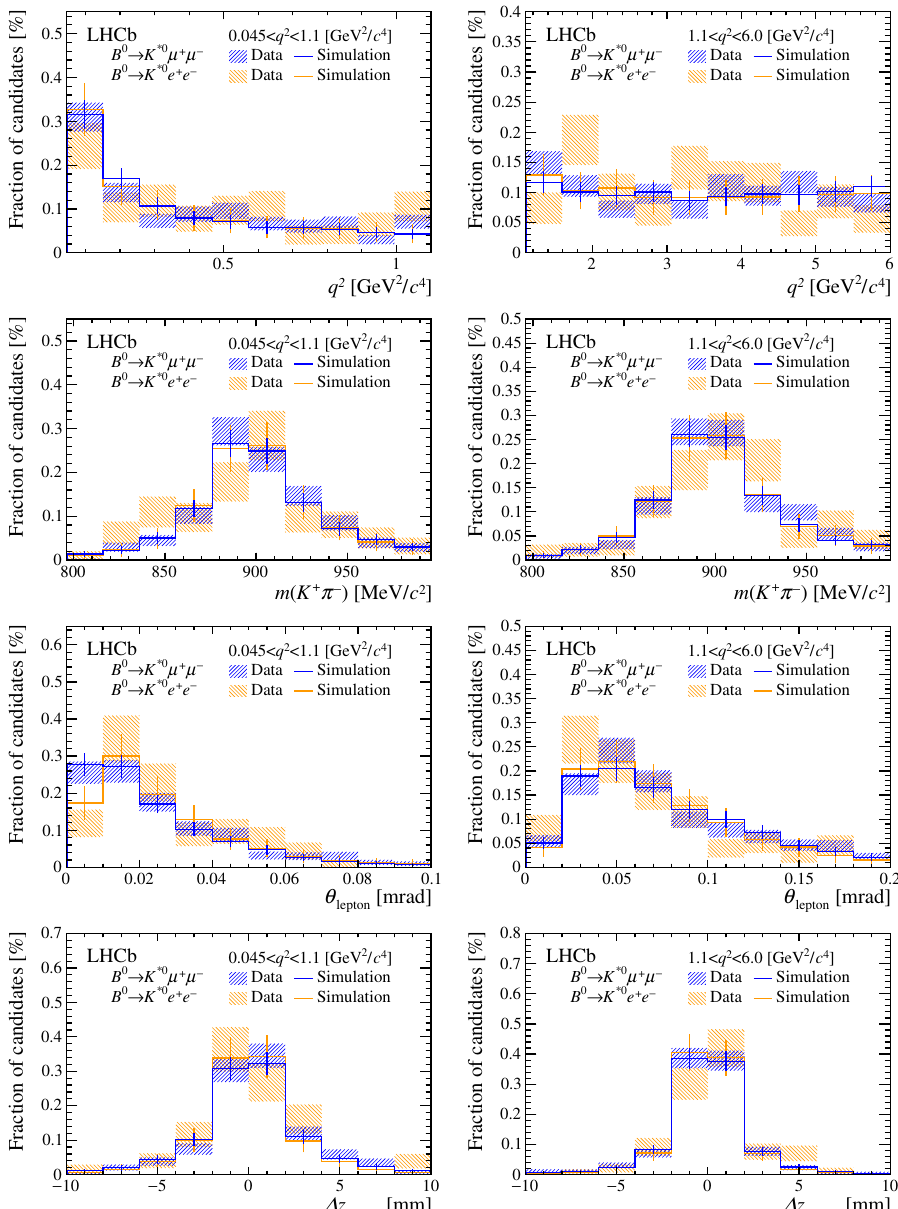
Figure 8 . (hatched) Background-subtracted distributions for (darker colour) B 0 ! K (cid:3) 0 (cid:22) + (cid:22) (cid:0) and (lighter colour) B 0 ! K (cid:3) 0 e + e (cid:0) candidates, compared to (full line) simulation. From top to bot- tom: q 2 , K + (cid:25) (cid:0) invariant mass, m ( K + (cid:25) (cid:0) ), opening angle between the two leptons, (cid:18) lepton , and projection along the beam axis of the distance between the K + (cid:25) (cid:0) and ‘ + ‘ (cid:0) vertices, (cid:1) z vertex . The distributions are normalised to unity. The hatched areas correspond to the statistical uncertainties only. The data are not e(cid:14)ciency